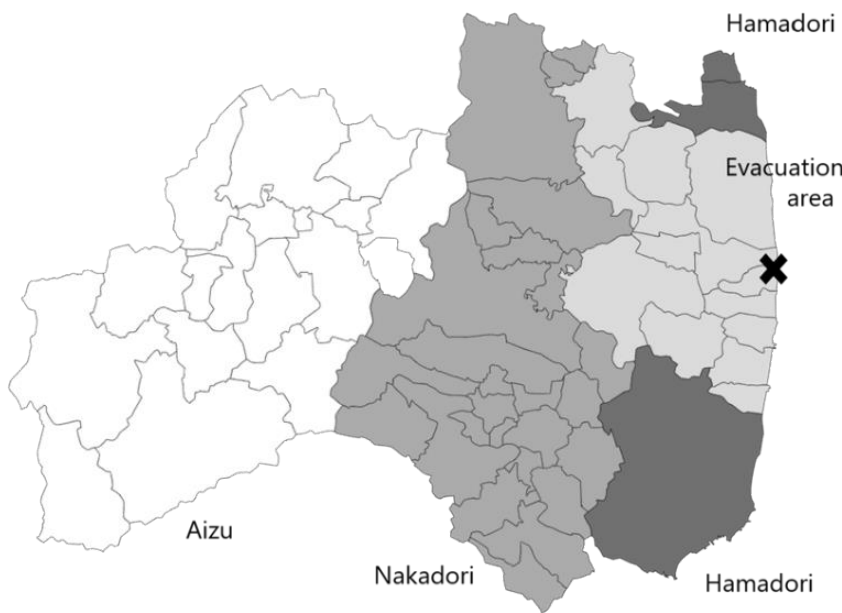
Figure 1. Evacuation area and areas in Fukushima. Regions colored in light gray correspond to the municipalities where evacuation orders were issued.